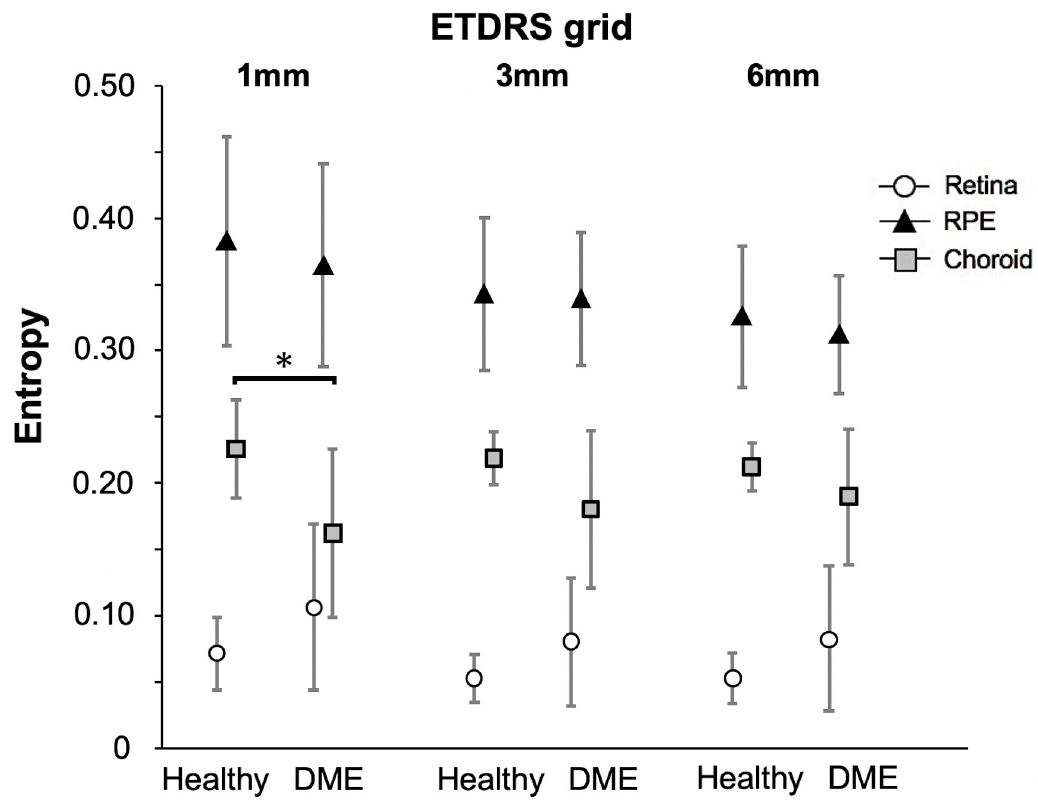
Fig 5. Comparison of the mean entropy value of each en face segmentation layers according to ETDRS grid between healthy subjects (n = 11) and patients with DME (n = 11). Mean entropy value in the choroid layer within the ETDRS circle with the diameter of 1 mm was a significantly lower in patients with DME than in healthy subjects (0.16 ± 0.064 vs 0.23 ± 0.037, P = 0.010), whereas in other circle ranges and strata, no difference was observed between patients with DME and healthy subjects. The ETDRS grid was used to demarcate nine zones delimited by solid circles with diameters of 1 mm, 3 mm, and 6 mm centered on the fovea; radial lines were projected onto the fundus to divide the OCT map into nine sectors. The results are the means ± standard